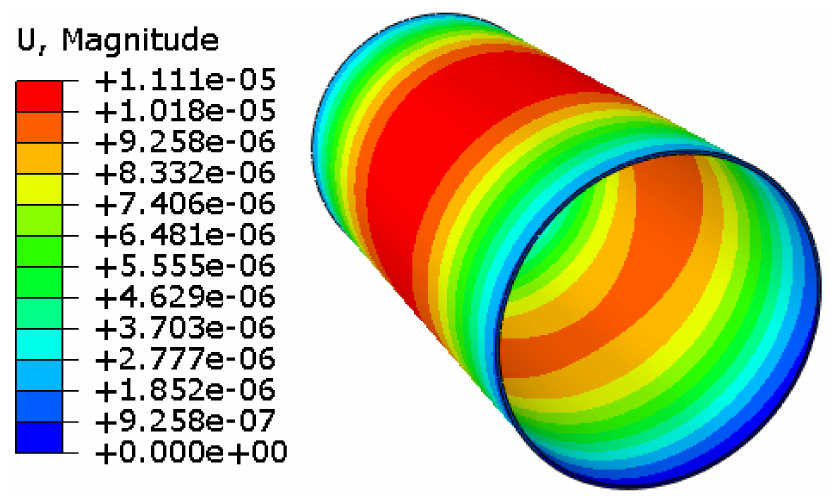
Figure 6. Deformation for the variable-stiffness cylinder.